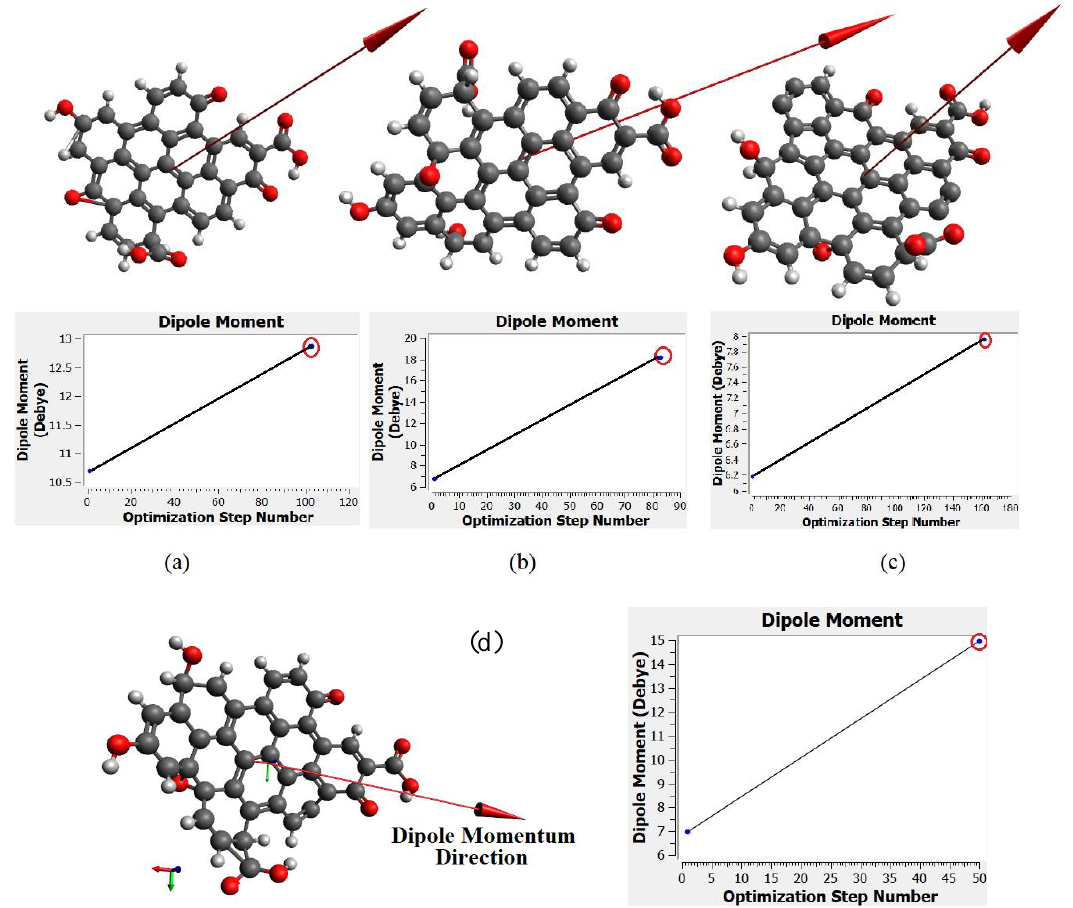
Figure 11. The momentum of molecule structure in the stable form related to ( a ) CQD with 9 rings (CAM-B3LYP), ( b ) CQD with 10 rings (CAM-B3LYP), ( c ) CQD with 10 rings (B3LYP), ( d ) CQD with 12 rings (CAM-B3LYP). Table 6. The e ff ective valance electron based on natural population